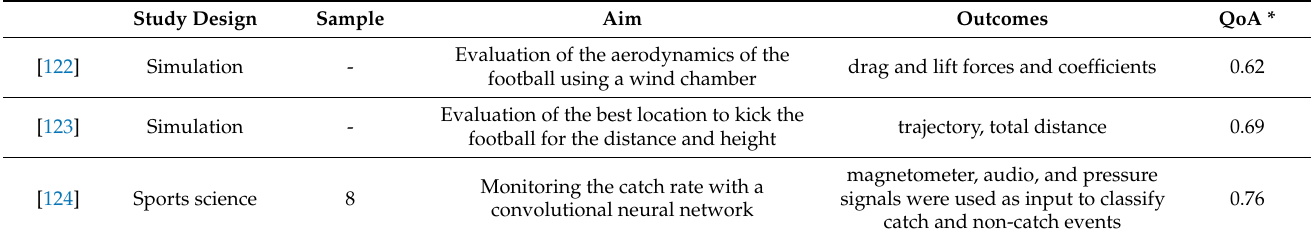
Table 8. Studies regarding AFC.